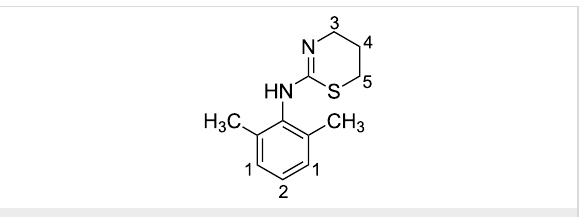
Figure 1: Structure of xylazine.